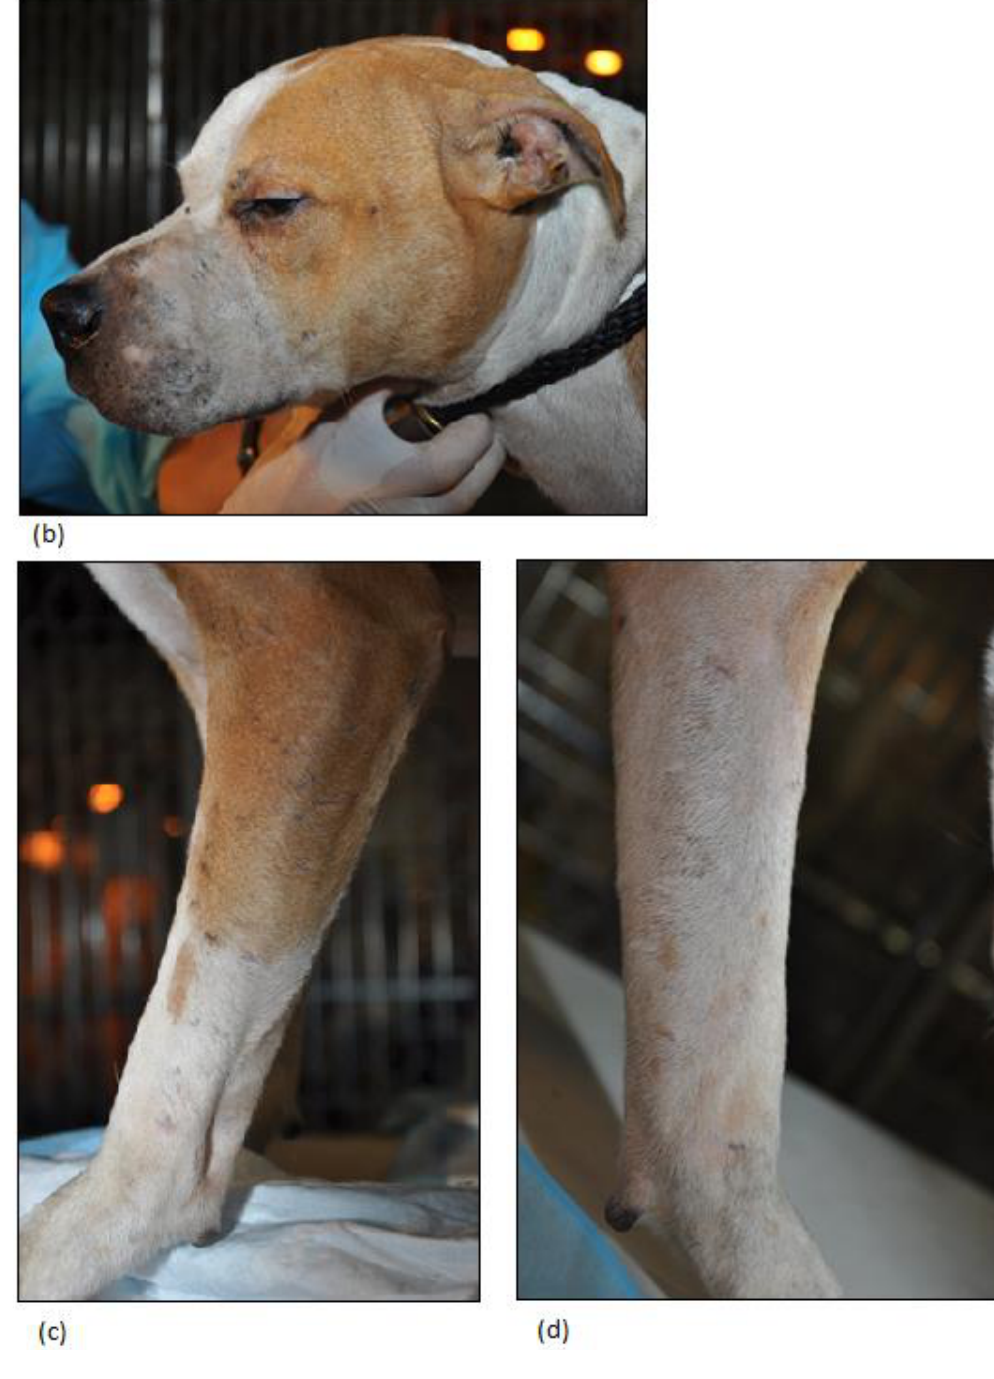
Figure B1. Sample scar chart and photographs of the wounds depicted. ( a ) Scar chart; ( b ) Scarring on left lateral aspect of head; ( c ) Scarring on lateral (outside) aspect of the left front leg; ( d ) Scarring on the medial (inside) aspect of the left front leg. A template for the scar chart is provided as Figure S1.